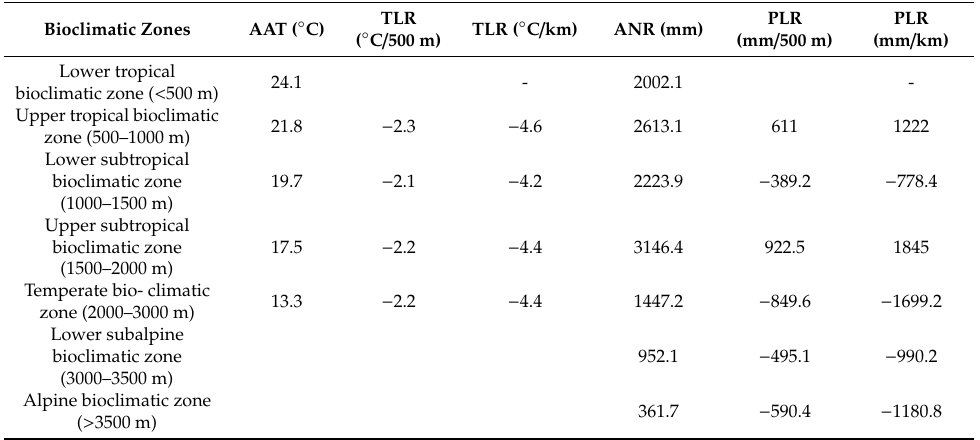
Table 5. Lapse rate and average temperature and precipitation along di ff erent bioclimatic zones in